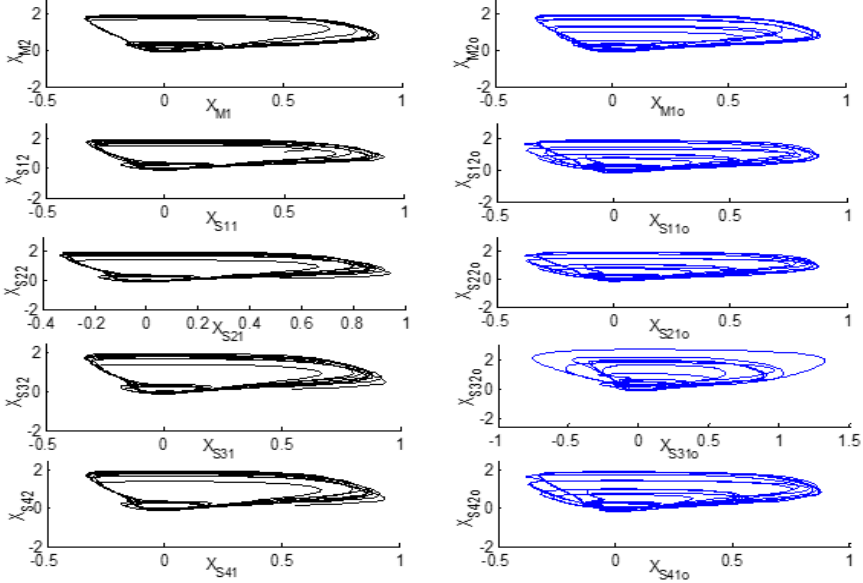
Figure 2. Phase portraits of master and slave systems of Theorem 2.